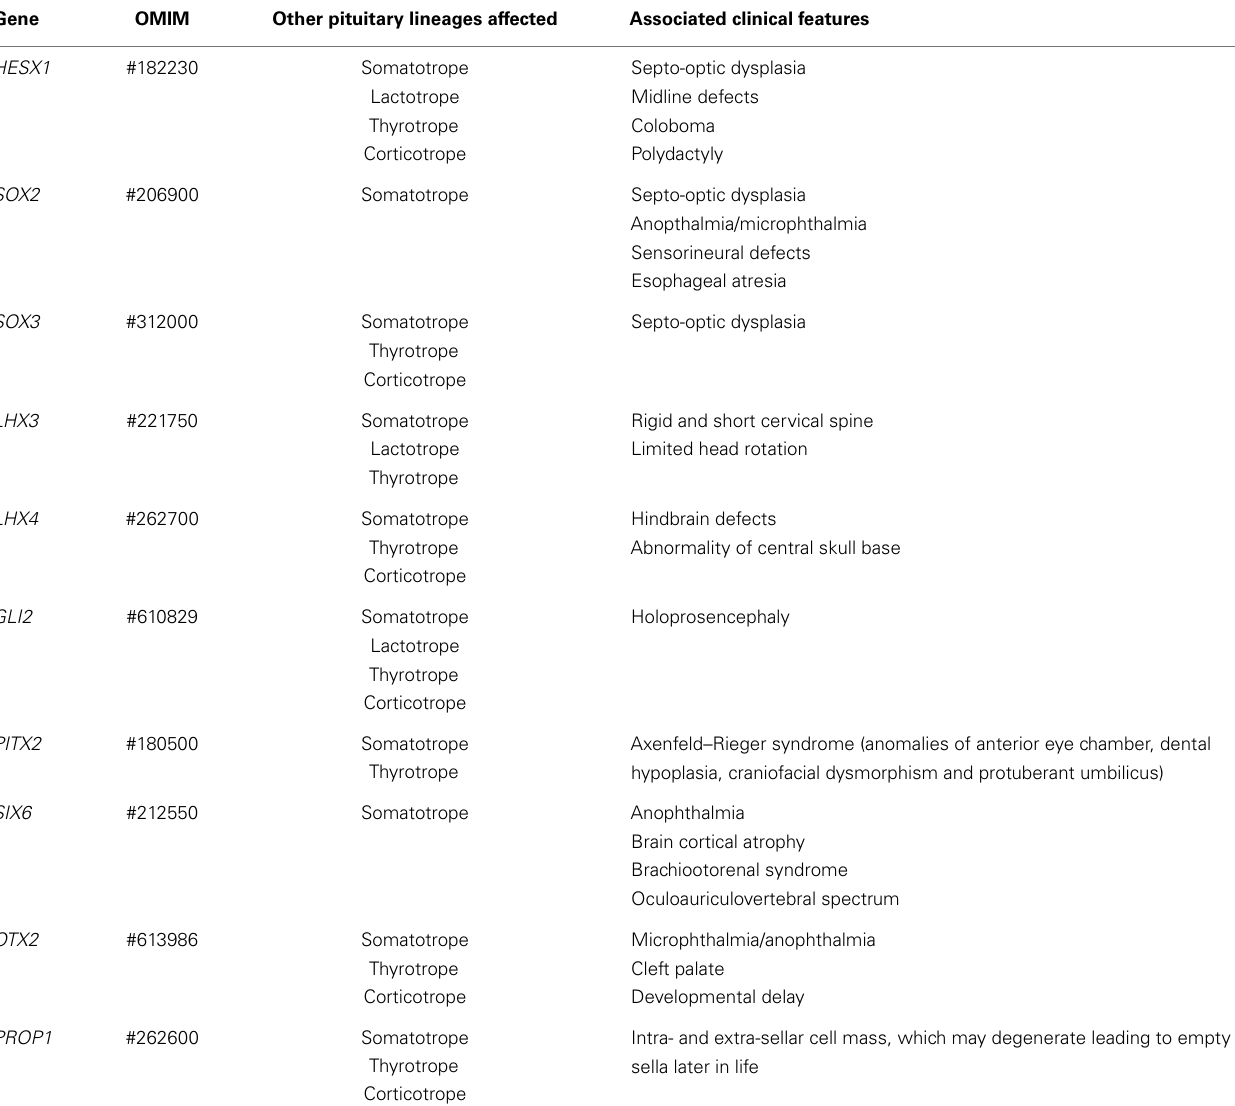
Table 4 | Clinical features in male patients with fetal-onset central hypogonadism associated with multiple pituitary hormone